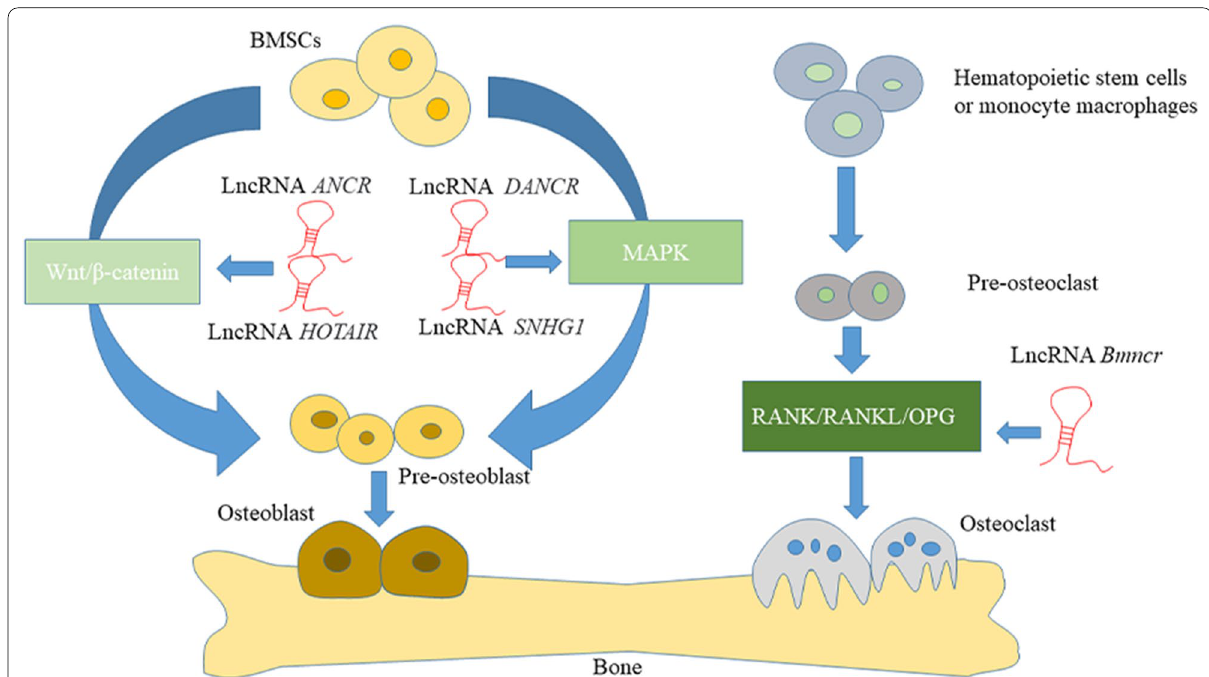
Fig. 1 Mechanisms of action of lncRNAs in bone development. LncRNA regulates osteogenic differentiation through Wnt/β-catenin and MAPK pathways. lncRNA ANCR and lncRNA HOTAIR affect the Wnt/β-catenin pathway and inhibit osteogenic differentiation. LncRNA DANCR and LncRNA SNHG1 regulate osteogenic differentiation through the MAPK pathway. LncRNA regulates osteoclast differentiation through RANK/RANKL/OPG and other pathways. LncRNA Bmncr inhibits RANKL-induced osteoclast